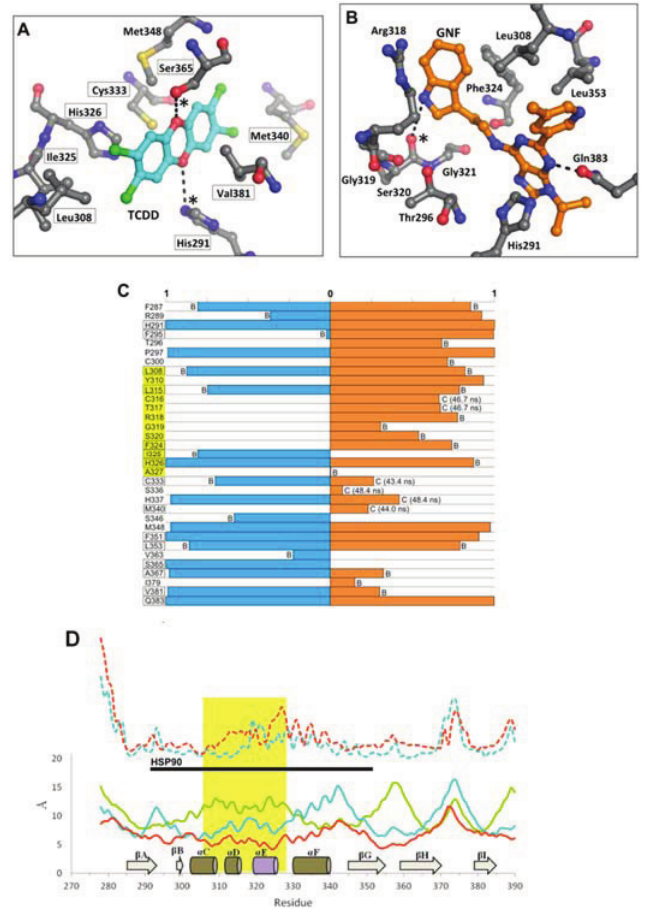
Figure 11. Environment and interactions of the bound ligands. ( A ) The environment of the ligand-binding cavity is shown for the equilibrated agonist MD model (at 50 ns) colored by atom: carbon, grey; oxygen, red; nitrogen, blue; sulfur, yellow. TCDD is depicted with sticks (with carbon atoms colored in cyan); active site residues that form transient hydrogen bonds with the buried polar groups of the ligand are noted with (*). The important interacting residues of the bound TCDD are shown, and residues which have been investigated via mutagenesis and found to influence TCDD binding are noted in black boxes [13,18]. ( B ) As in panel A, the active site cavity is shown for the equilibrated antagonist MD model (at 50 ns). ( C ) Residues contacting the ligand (within 4 Å) during the final 10 ns of simulation are shown with the percentage of contact time noted for agonist MD (blue) and antagonist MD (orange). For those with less than 90% contact time over the final 10 ns, we note whether this is due to fluctuation from being on the pocket boundary (denoted with “B”) or due to a conformational shift (denoted with “C”), for which we also note the time of occurrence. ( D ) Shown is a plot of root mean square fluctuation of C(cid:2) atoms to illustrate structural dynamics for apo MD (solid green) agonist MD (solid cyan), antagonist MD (solid orange) as calculated by VMD [33] during the last 5 ns of simulation. The C(cid:2) shifts between apo MD and agonist MD (dashed cyan) and between apo MD and antagonist MD (dashed orange) are also shown on the same scale, but for clarity their values are adjusted +20 Å. The 307–329 segment is highlighted in gold, with the secondary structure of the apo MD given for reference, and the regions interacting with HSP90 in the murine system are noted by the black